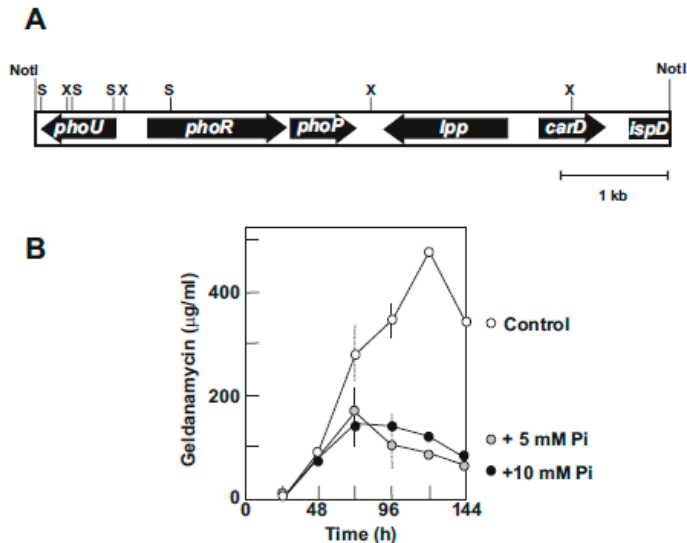
Figure 4. Phosphate control of geldanamycin production. ( A ) Organization of the pho genes and the surrounding region in a NotI DNA fragment of S. hygroscopicus var. geldanus NRRL 3602. Restriction sites for XhoI (X) and SalI (S) are indicated. ( B ) Production of geldanamycin in SPG medium (white circles) and SPG medium supplemented with 5 mM (gray circles) and 10 mM inorganic phosphate (black circles).